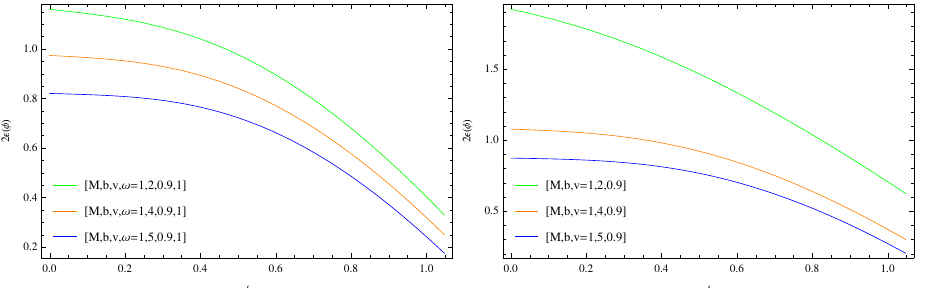
Figure 5. ( left ) The variation in the angle between radial direction and direction of the particle motion is shown, i.e., ψ ( φ ) is shown against φ for different values of v . ( right ) ψ ( φ ) is shown against φ for different values of v , for Schwarzschild case.